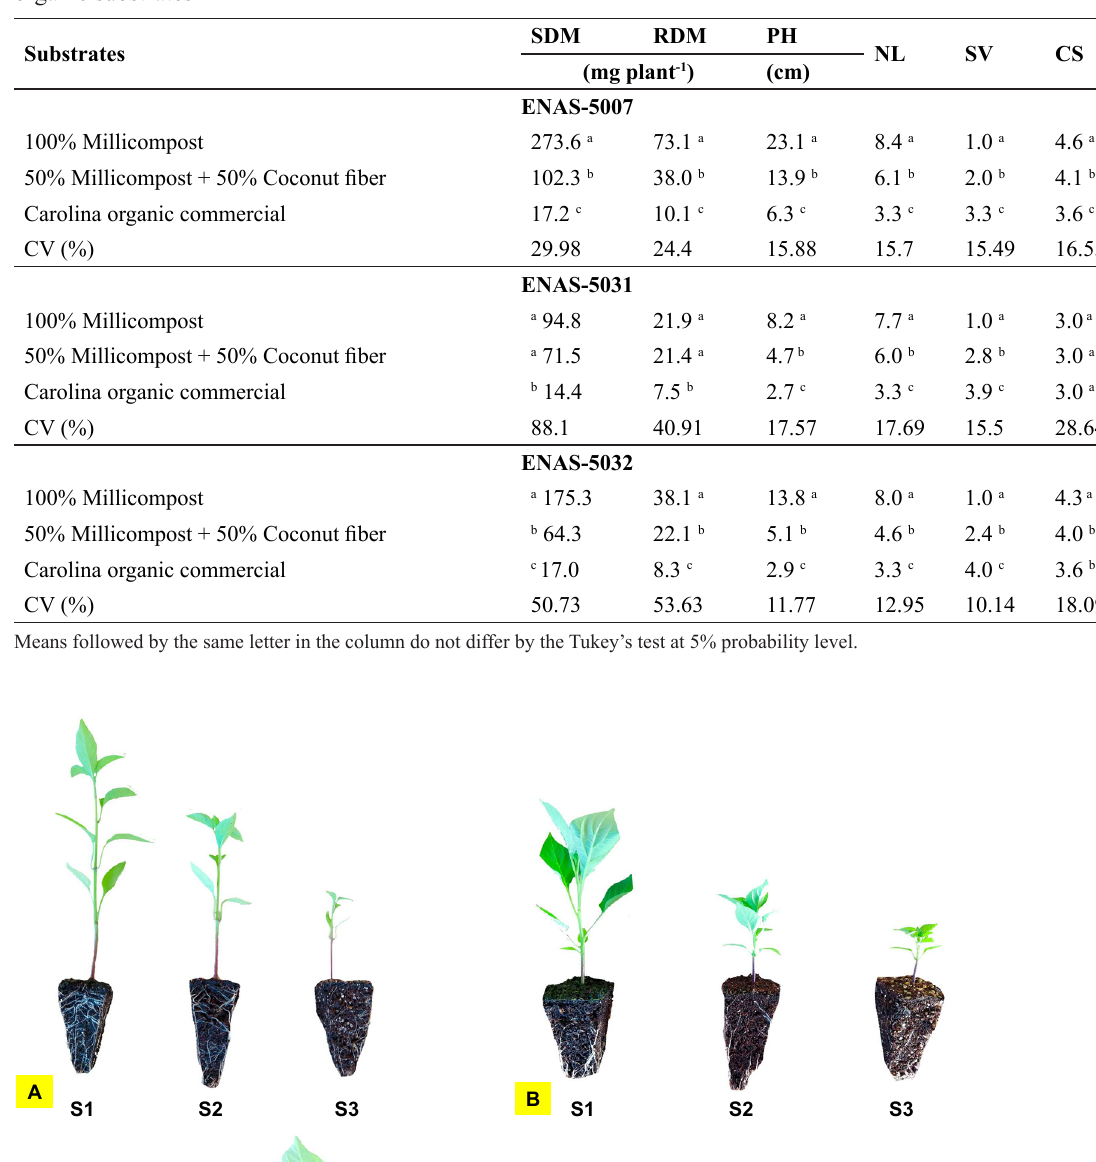
Table 4 Average values of shoot dry mass (SDM), root dry mass (RDM), plant height (PH), number of leaves (NL), seedling vigor (SV) and clod stability (CS) obtained from seedlings of the three pepper genotypes developed on